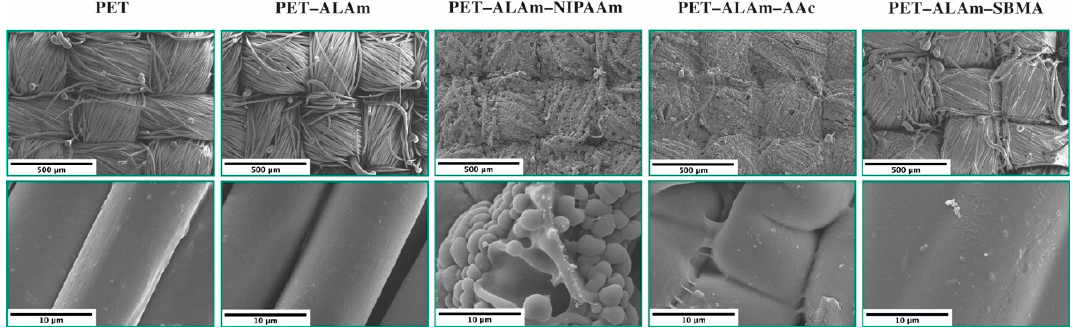
Figure 4. SEM morphologies of pristine PET, PET modified with allylamine (PET-ALAm), and hydrogel modified PET fabrics.